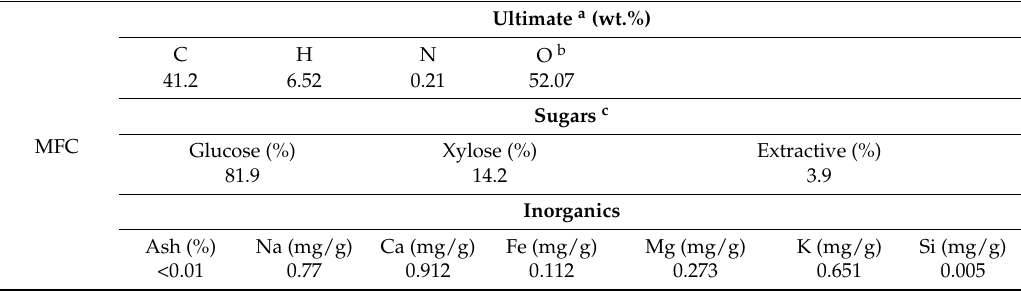
Table 2. Cellulose microfiber (MFC) compositional analysis.